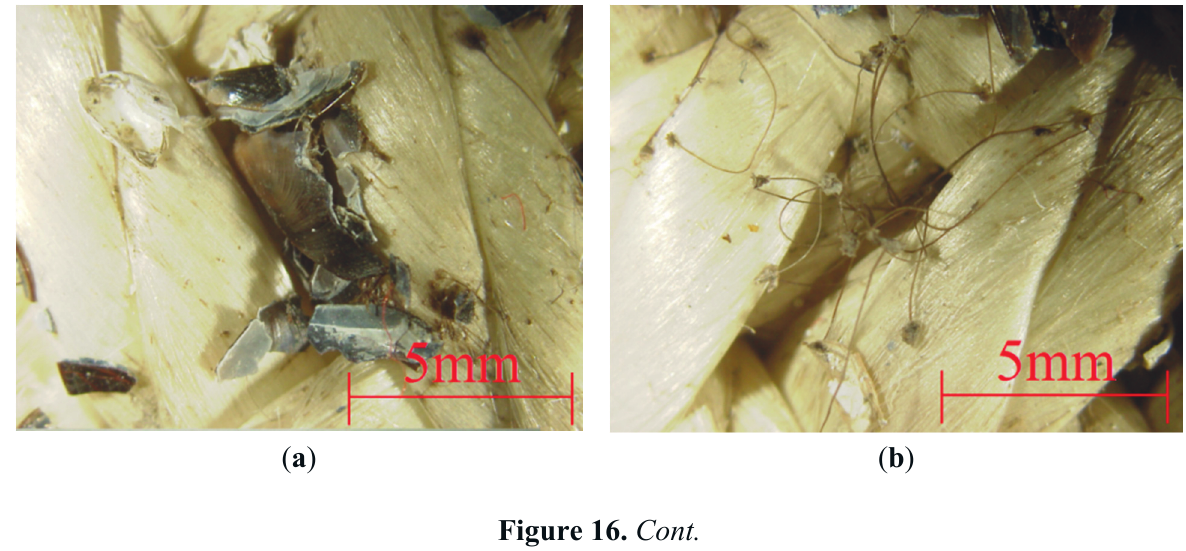
Figure 15. Internal view of P1-8 following sea trials, debris from marine growth is evident on the anti-friction